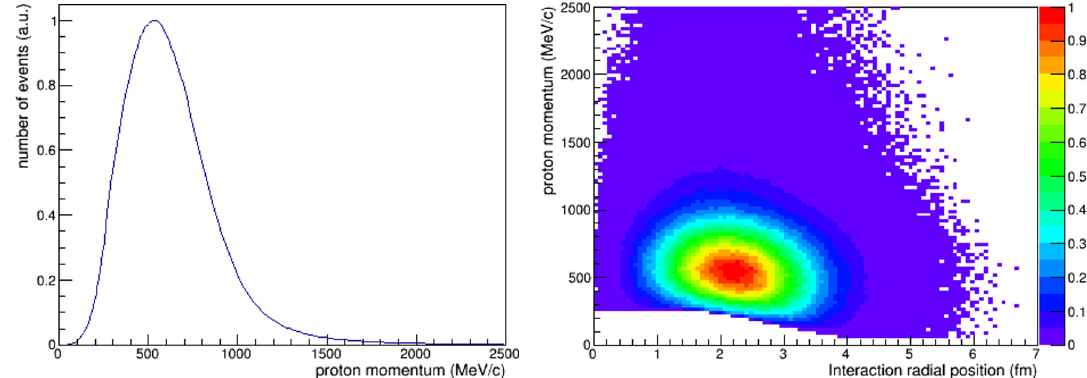
Figure 4 . Left: primary proton, created after the absorption of the gauge boson W + in neutrino processes, momentum distribution in carbon predicted by the model. Right: proton momentum distribution predicted by the model as function of the radial interaction point inside the nucleus. As in figure 1, results have been folded with the T2K neutrino energy